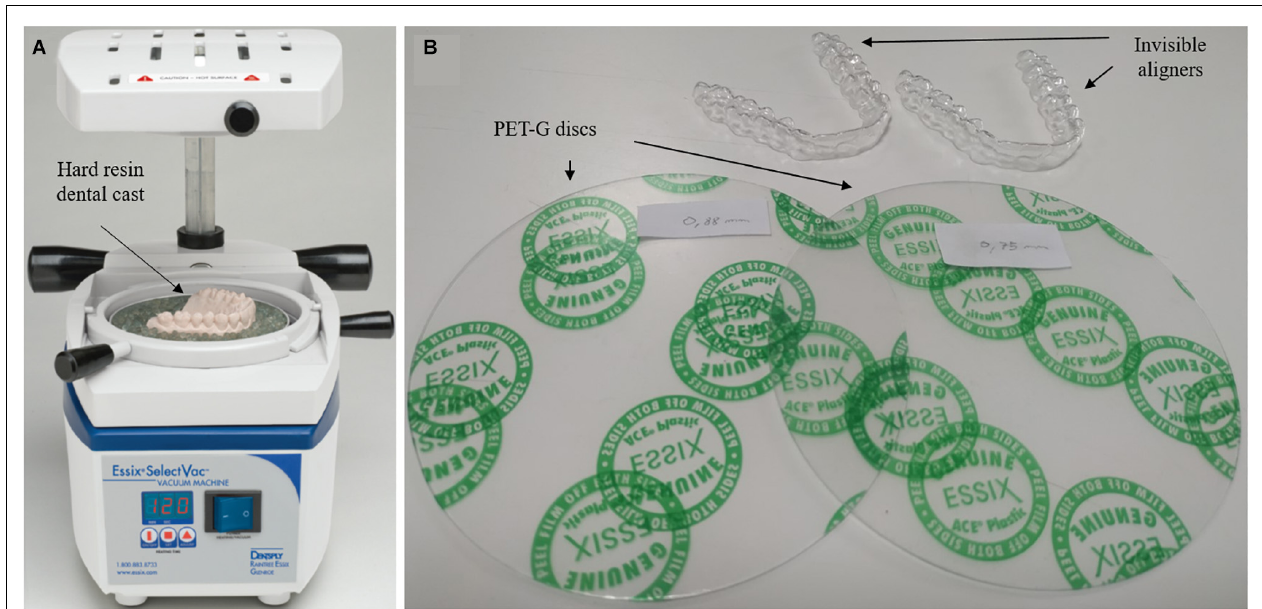
FIGURE 1 | (A) Essix R (cid:13) SelectVac vacuum machine used for fabricated the invisible aligners and (B) PET-G discs used and specimen